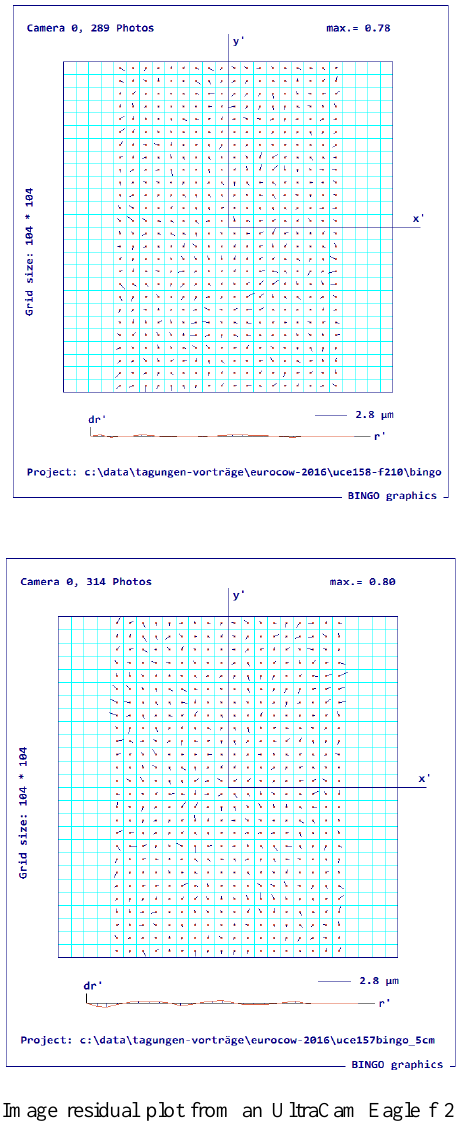
Fig.3: Image residual plot from an UltraCam Eagle f 210 mm flight mission (left) and an UltraCam Eagle f 100 mm focal lens (right). Maximum residuals are at 0.8 µm